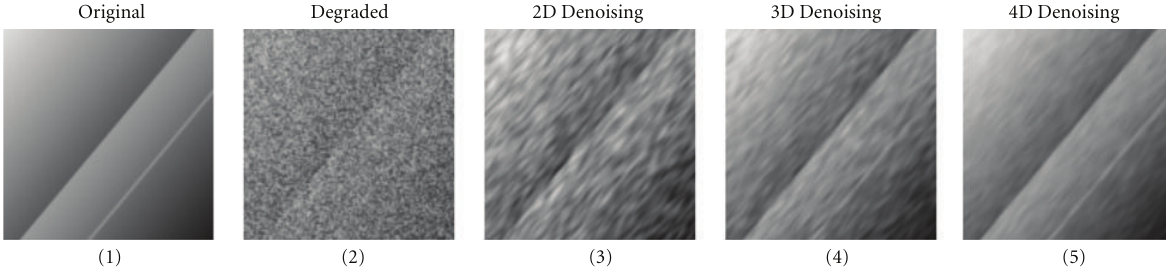
Figure 1: (1) Original test image without noise. There is a large step in the middle, a bright thin line and a shading from the top left corner to the bottom right corner. (2) Original test image with a lot of noise. The step is barely visible, while it is impossible to see the line or the shading. (3) Resulting image after 2D denoising. The step is almost visible and it is possible to see that the top left corner is brighter than the bottom right corner. (4) Resulting image after 3D denoising. Now the step and the shading are clearly visible, but not the line. (5) Resulting image after 4D denoising. Now all parts of the image are clearly